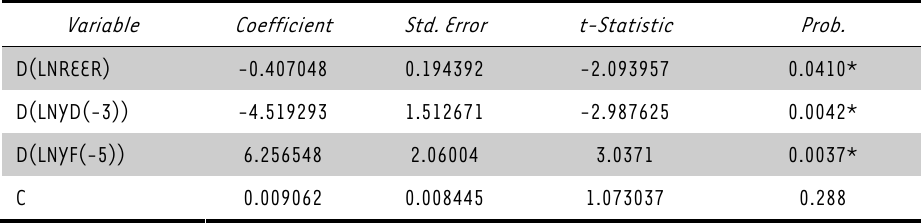
TABLE 3: Short run elasticities – Newey-West method